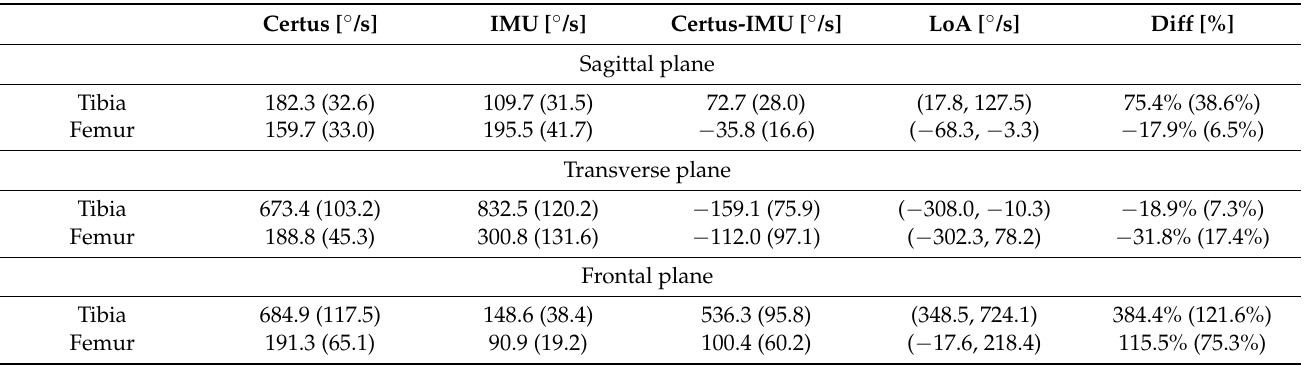
Table 3. Mean (SD) values for Bland–Altman comparisons of peak angular velocity from Certus and IMUs for the three planes. On average, the Certus measurements tended to overestimate the IMU measurements. The percentage difference (Diff [%]) is defined in the table